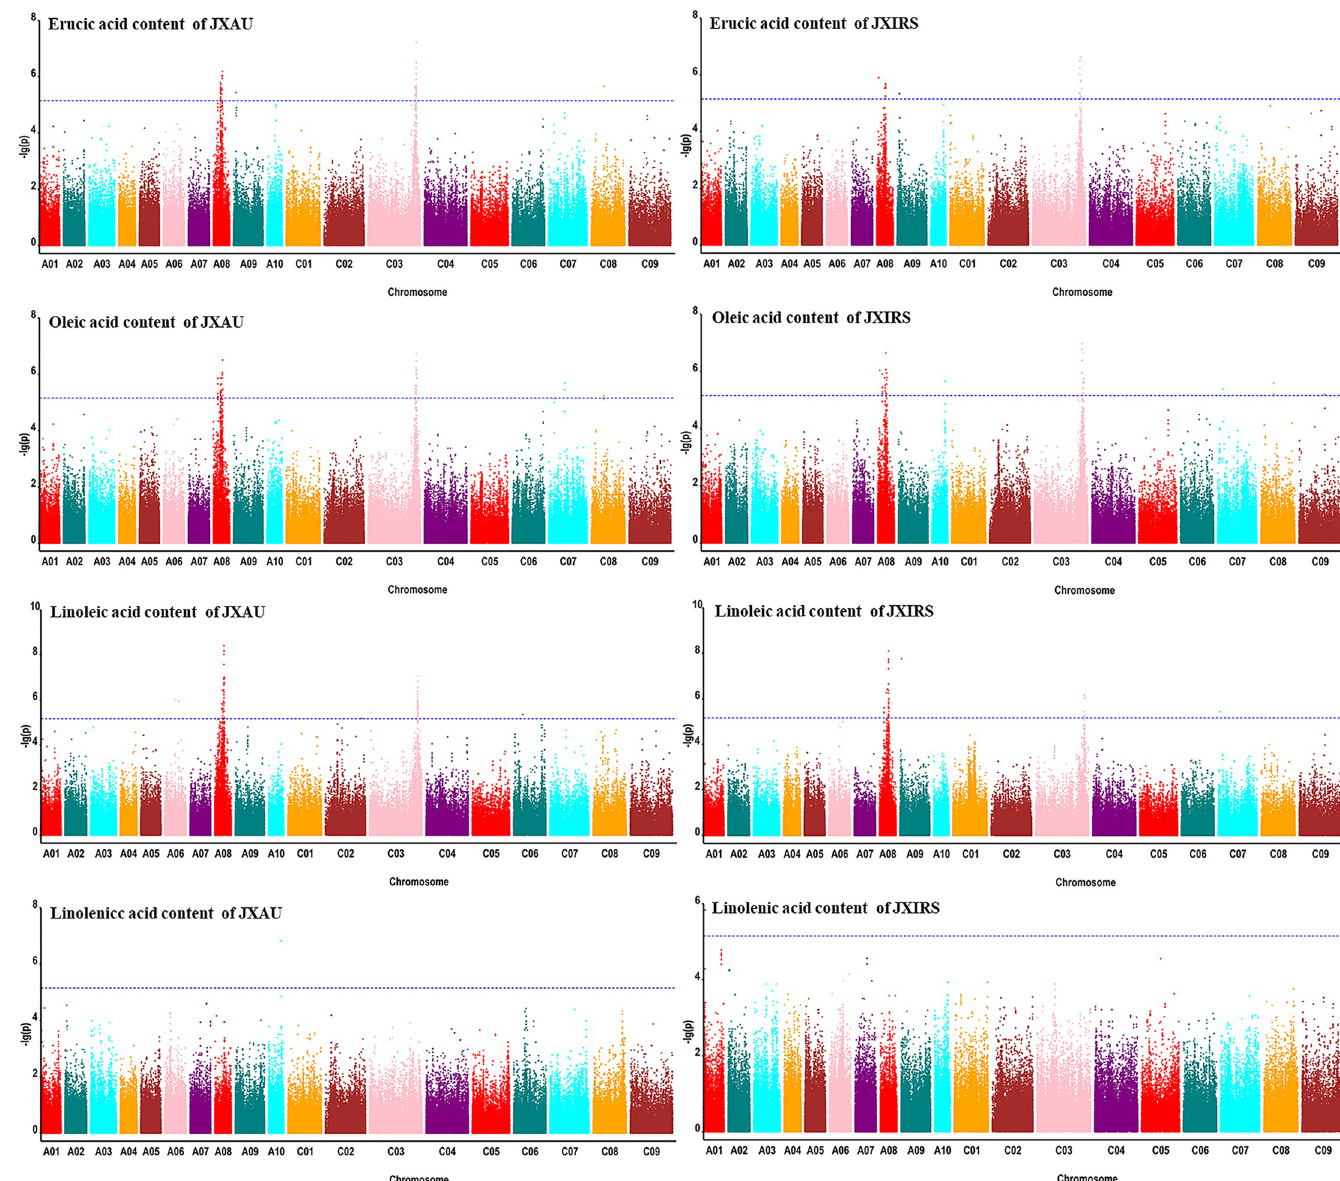
Fig 3. Manhattan of GWAS for four fatty acid content traits of B . napus by MLM in two environments (JXAU and JXIRS).